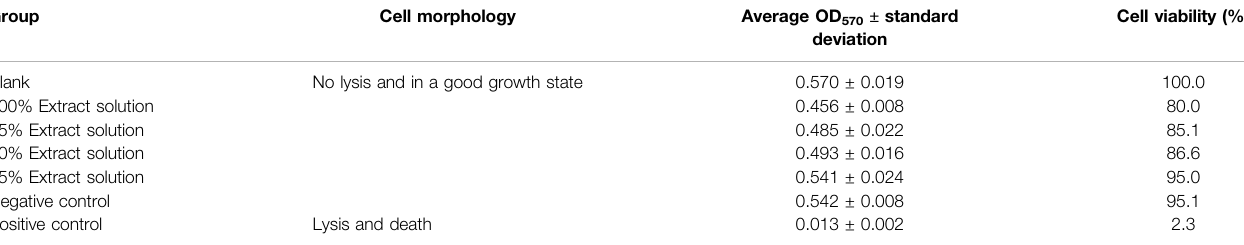
TABLE 1 | Cell viabilities after 24 h incubation in the media containing different volume fractions of Fe 3 O 4 @Agar/HA extract solution ( n (cid:2) 6).